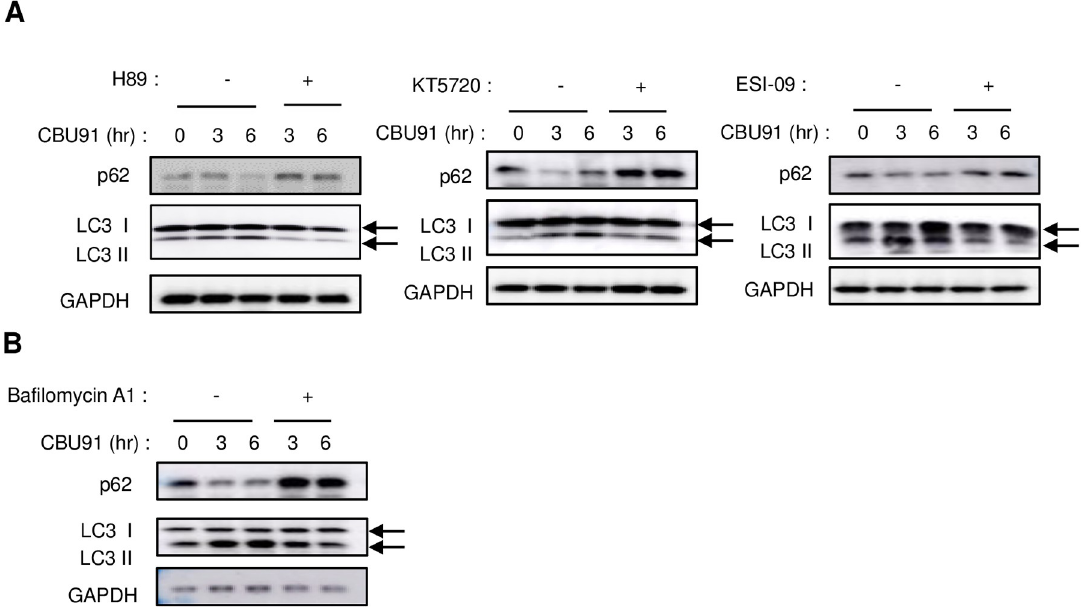
Fig 5. CBU91 increases autophagy. A, Expression level of LC3-I/II and p62 after treatment with CBU91 (10 μ M) in the presence of the PKA inhibitors (H89, KT5720) or EPAC inhibitor (ESI-09). B, Expression level of LC3-I/II and p62 after treatment with CBU91 (10 μ M) in the presence of the lysosomal inhibitor (Bafilomycin